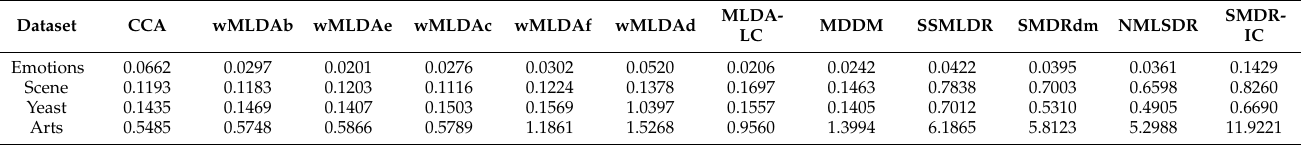
Table 6. Calculation time (s) of different methods on four data